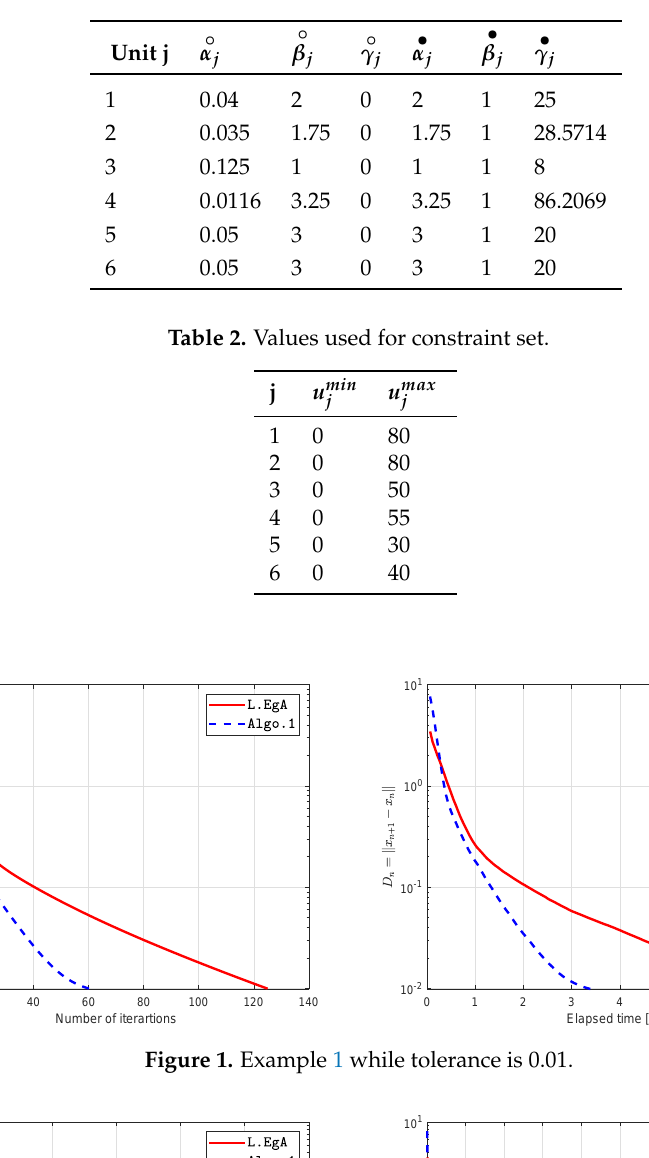
Table 1. Parameters for cost bi-function.